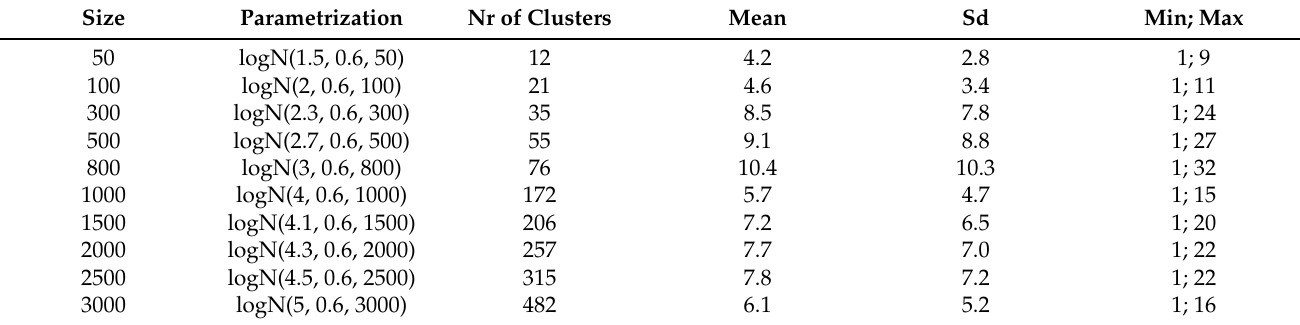
Table 1. Node cluster size statistics of different LognormalSeq parametrizations. Size: number of nodes. Parametrization: Parameters of the lognormal sequence parametrization methods. Nr of clusters: number of node clusters. Mean: mean size of node clusters. Sd: standard deviation of node cluster size. Min; max: minimum and maximum node cluster